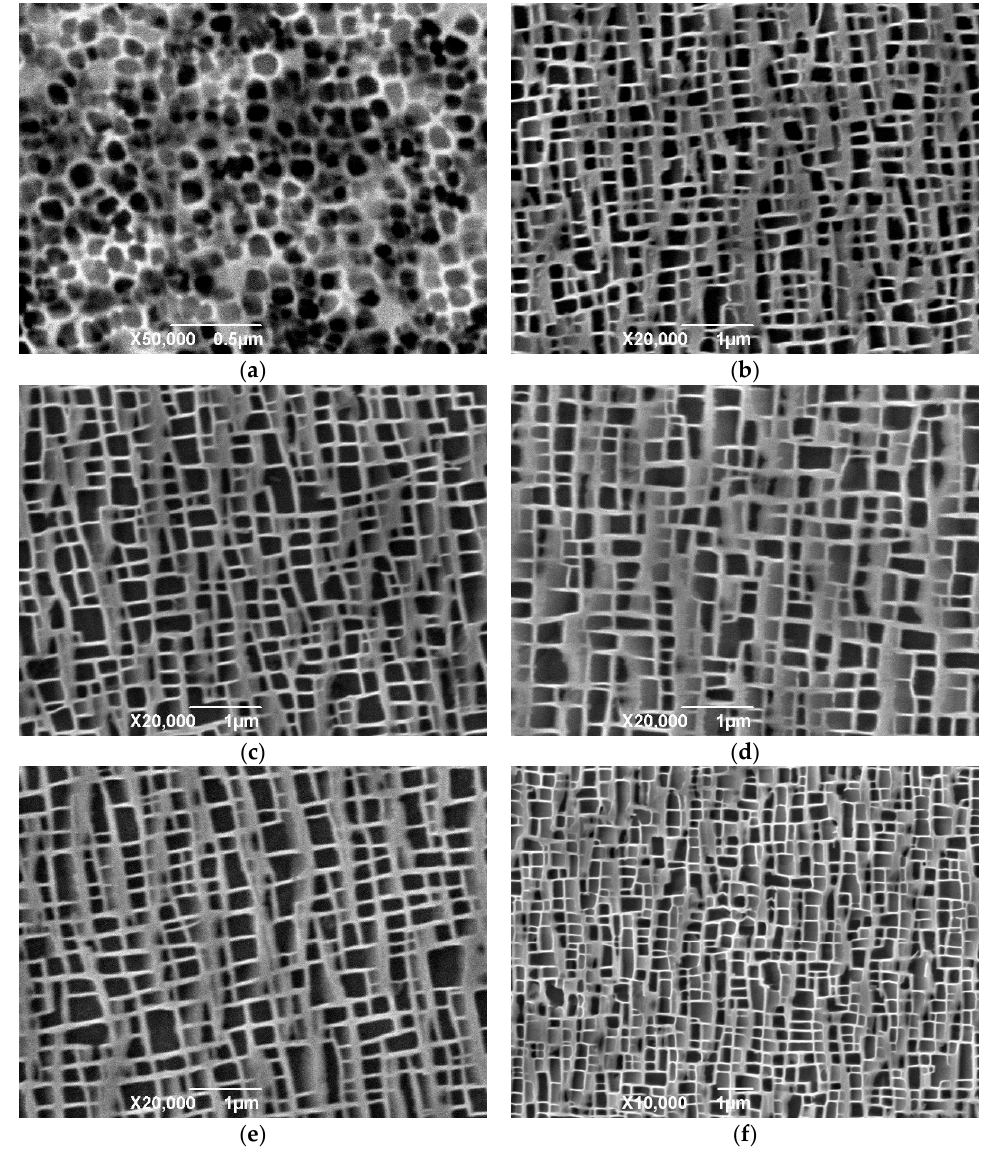
Figure 7. Microstructure of the samples after different aging treatments ( a ) Non-aging, ( b ) Aging system ① , ( c ) Aging system ② , ( d ) Aging system ③ , ( e ) Aging system ④ , ( f ) Aging system ⑤ .